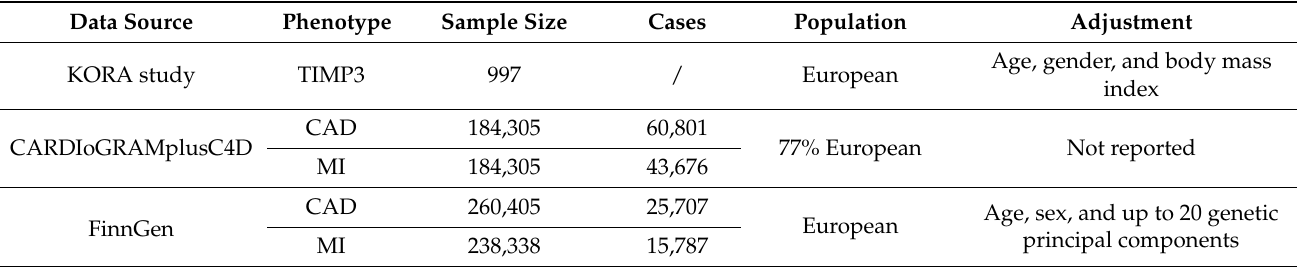
Table 1. Detailed information of studies and datasets used for